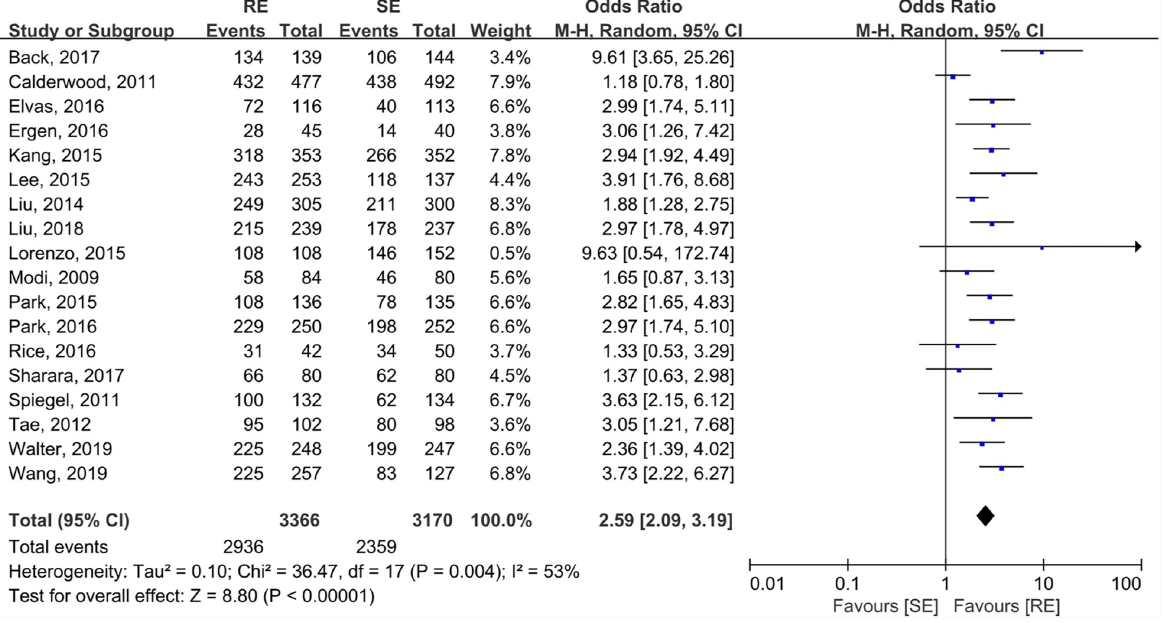
Fig 2. Forest blot comparing the pooled BP quality between RE and SE groups. colon (right, transverse, and the left side of the colon), each of which was assigned a score rang-